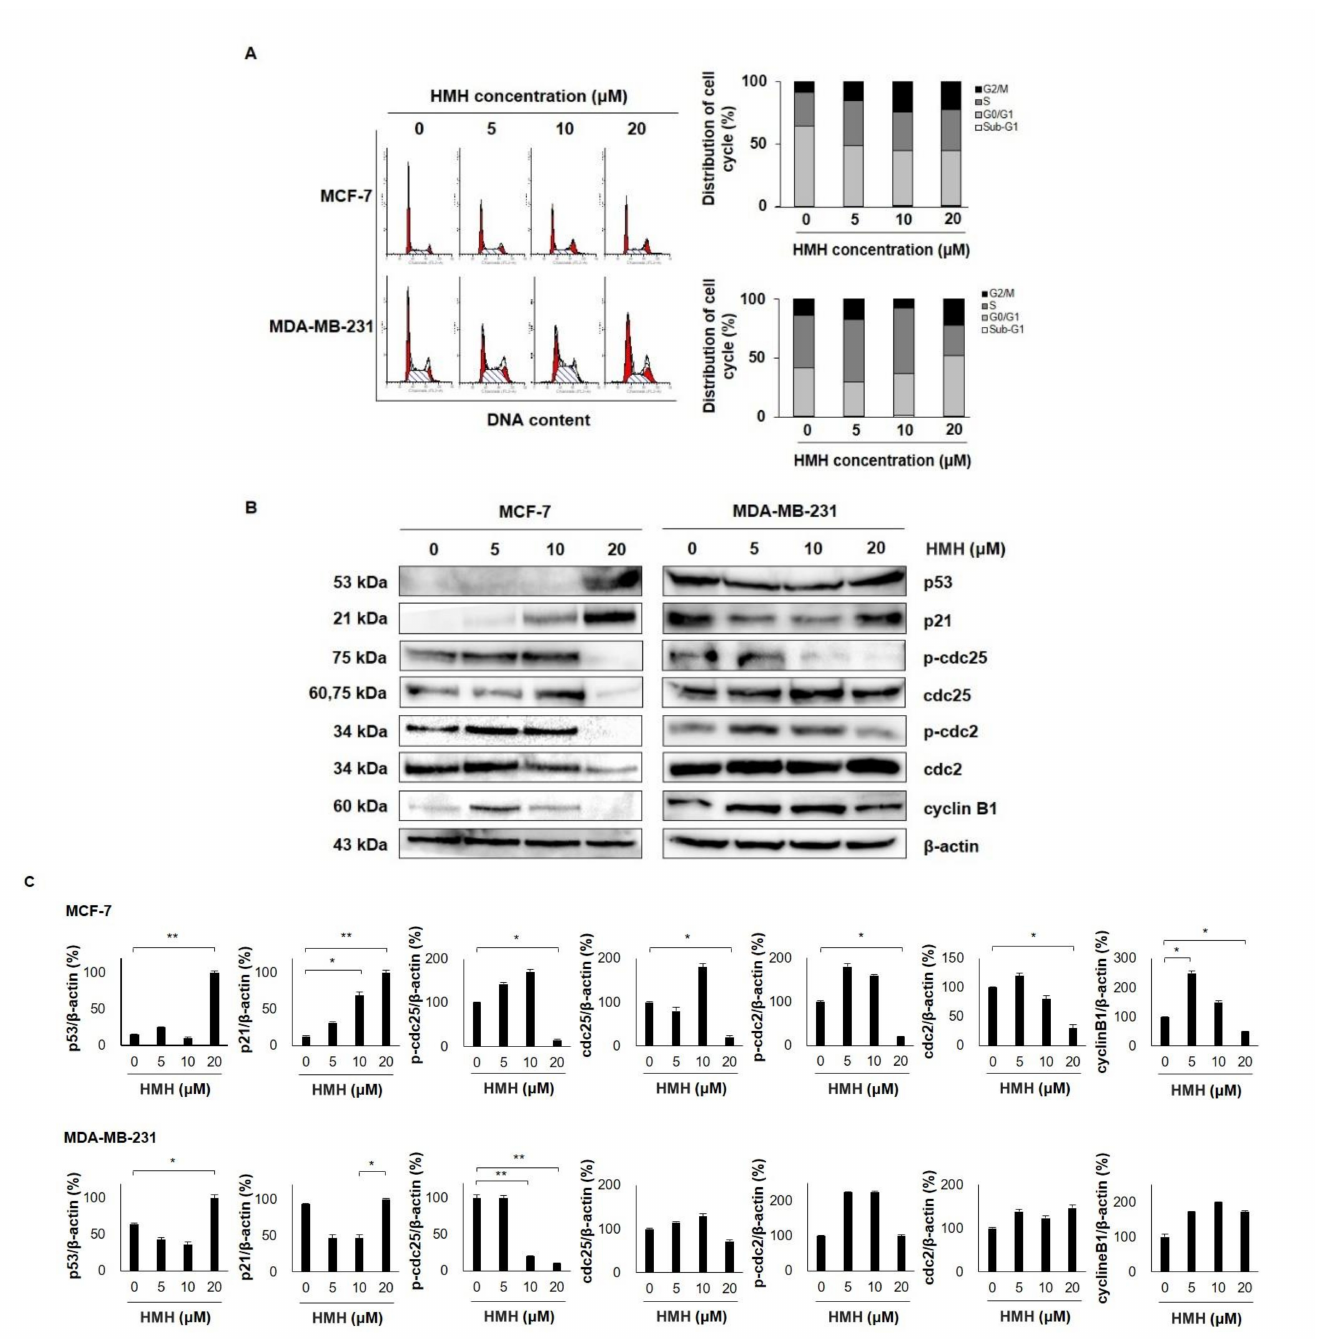
Figure 6. Effects of harmine hydrochloride on the cell cycle progression of MCF-7 and MDA-MB-231 cells. ( A ) The MCF-7 and MDA-MB-231 cells were treated with harmine hydrochloride (0, 5, 10, and 20 µ M) for 48 h. Then, the cells dyed with propidium iodide (PI) were analyzed with flow cytometry to identify cell cycle progression. The cumulative distribution of the cells in Sub-G1, G0/G1, S, and G2/M phases was identified in the MCF-7 and MDA-MB-231 cells following harmine hydrochloride treatment. Harmine hydrochloride treatment induced the G2/M cell cycle in a dose-dependent manner. ( B ) The expression levels of proteins associated with G2/M, including p53, p21, p-cdc2, cdc2, and cyclin B1, were identified in MCF-7 and MDA-MB-231 cells using western blot. β -actin was used as an internal control. Full images can be found in the Supplemental Materials. ( C ) Band intensity was normalized using β -actin. Values indicate the mean ± SD. * p < 0.05, ** p < 0.01 as shown by the Student’s t